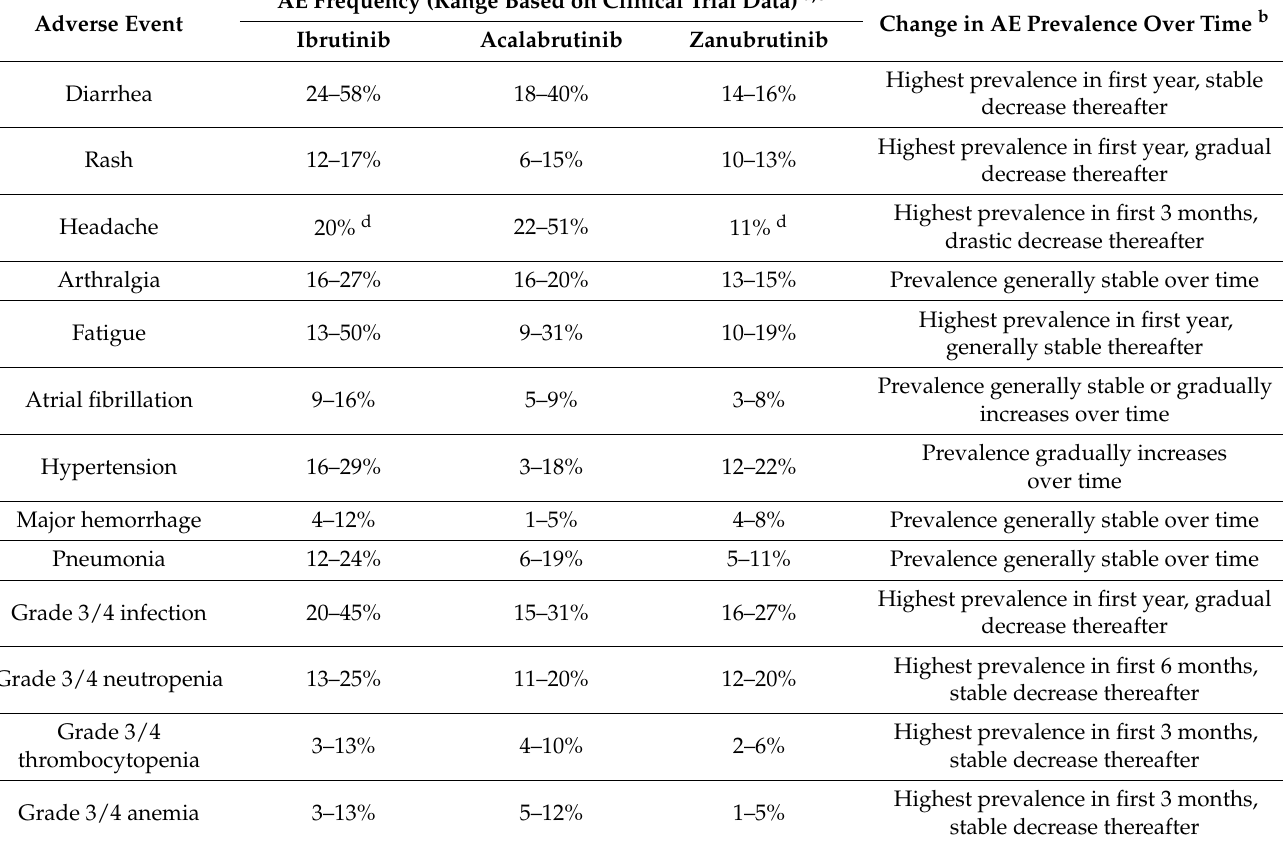
Table 4. Frequency and temporal changes in adverse events reported in clinical trials of BTK inhibitors in B-cell